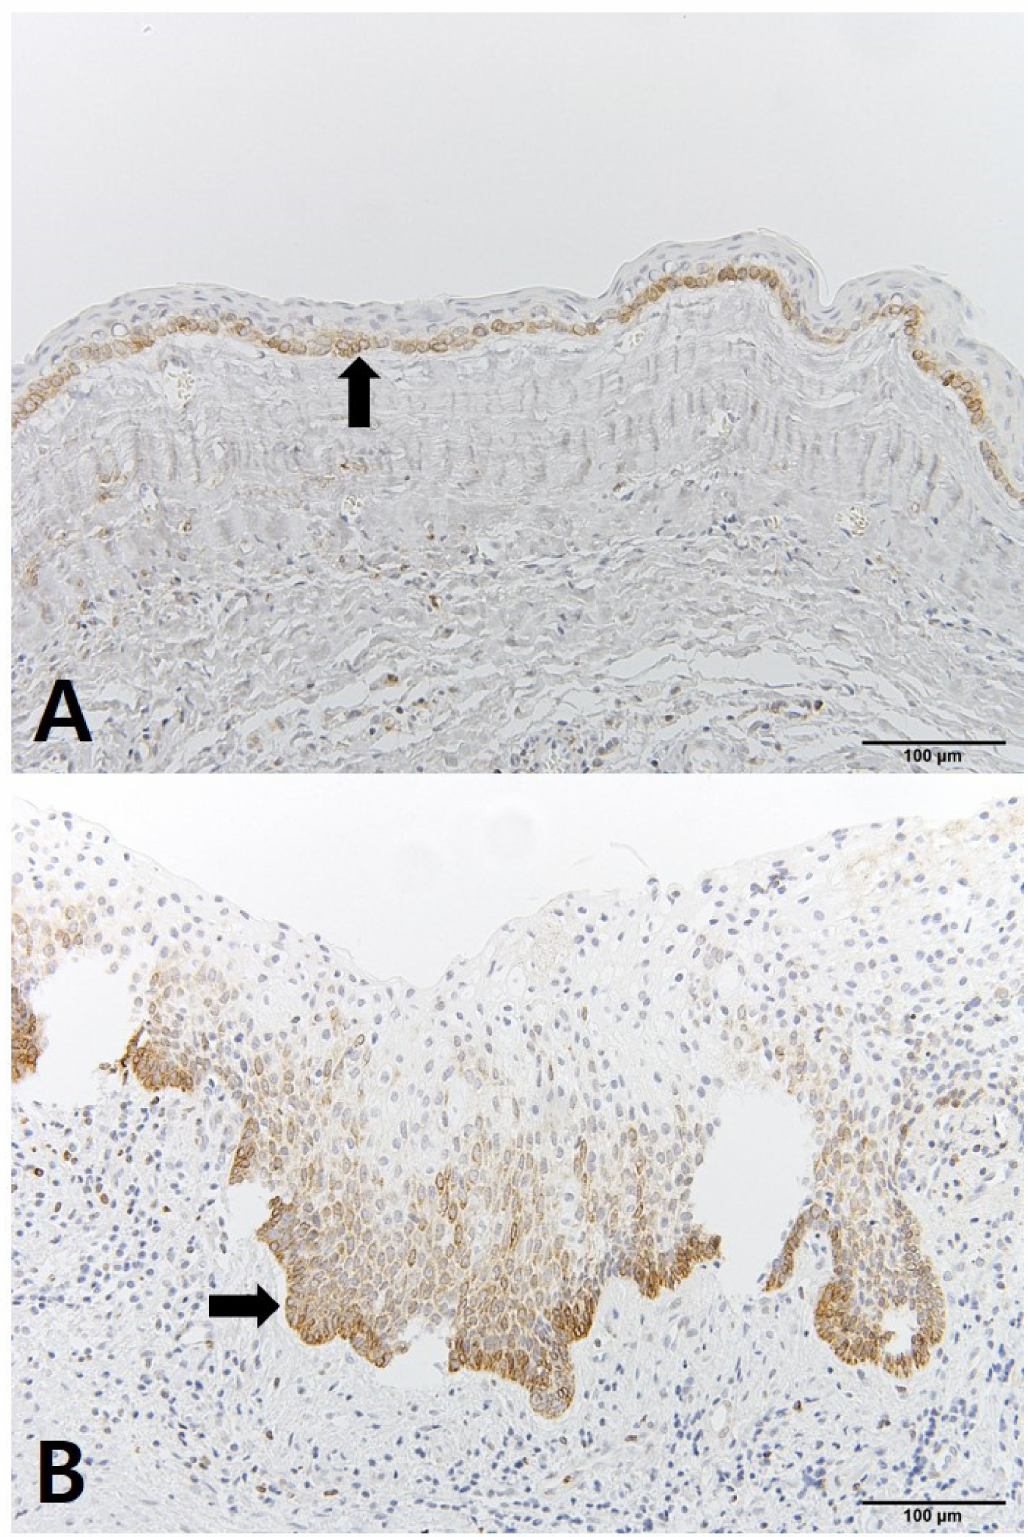
Figure 4. IHC staining of Bcl-2: ( A ) tissue obtained at decompression; ( B ) tissue obtained